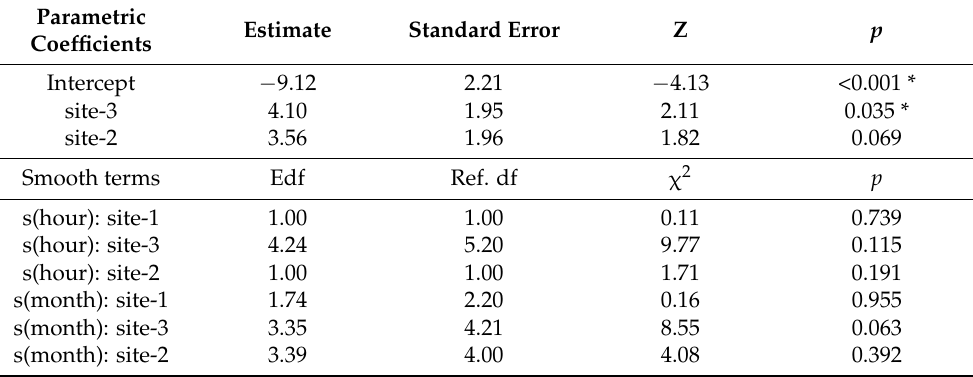
was modeled using a cyclic cubic regression spline. Reference degrees of freedom was used to